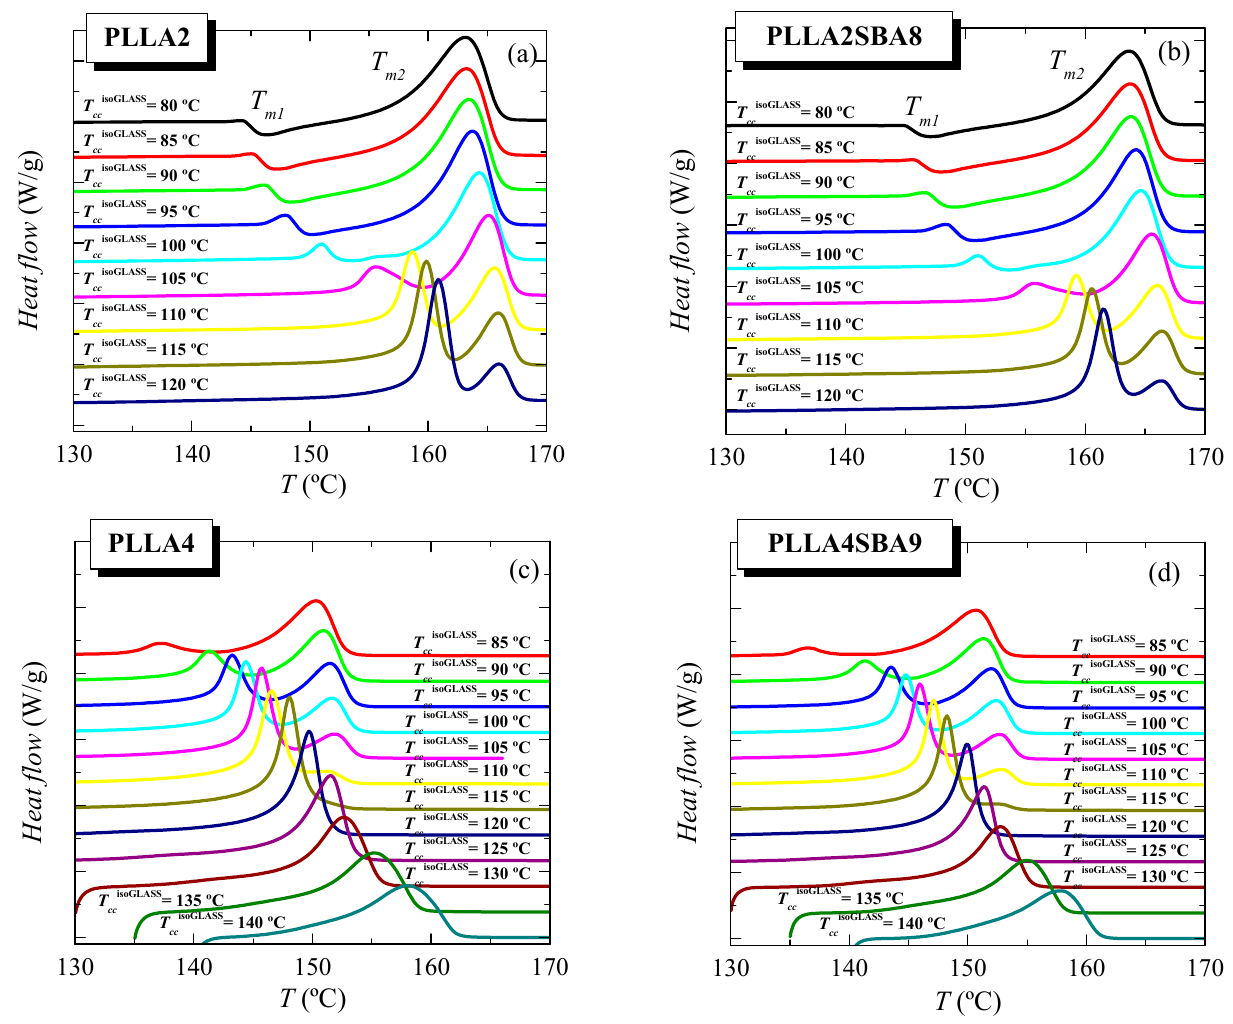
Figure 6. Melting behavior as a function of temperature used for isothermal crystallization from the glass, T cc isothermGLASS , for ( a ) neat PLLA2, ( b ) its composite PLLA2SBA8, ( c ) pristine PLLA4, and ( d ) its composite PLLA4SBA9.